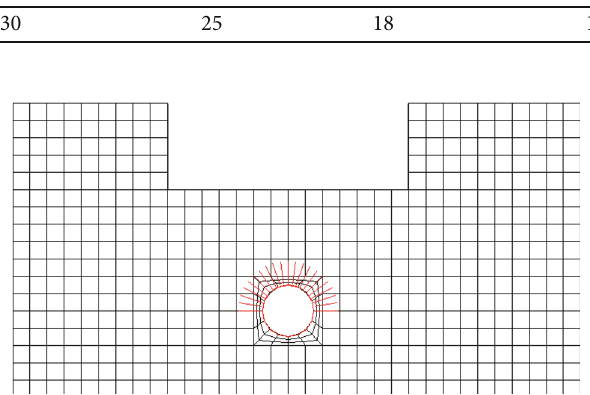
Figure 2: Numerical calculation model.